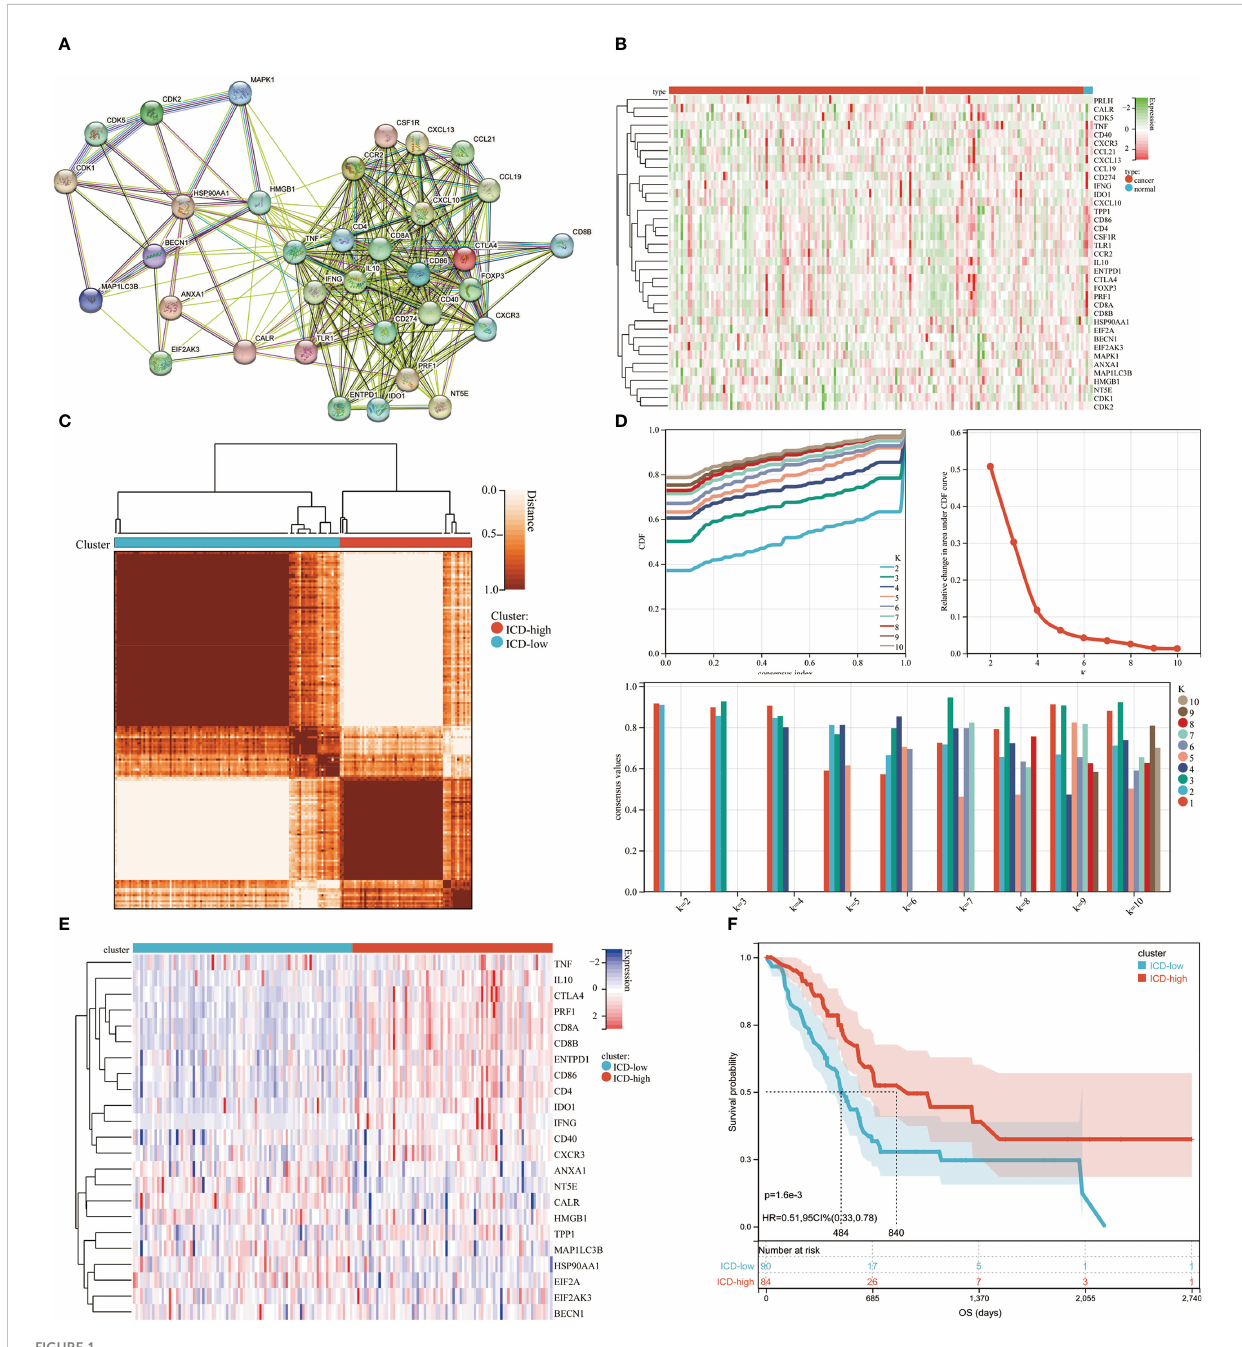
FIGURE 1 Consensus clustering for the identi fi cation of subtypes related to ICD. (A) PPI (Protein-protein interactions) among the genes related to ICD; (B) The TCGA database heatmap displays 37 ICD gene expression patterns in normal and PDAC samples; (C) The consensus clustering solution (k = 2) for 23 genes in 176 PDAC samples is represented by a heatmap; (D) Consensus clustering ’ s delta area curve showed the change in area under the cumulative distribution function (CDF) curve for k = 2 to 10; (E) Heatmap of 37 ICD-associated genes ’ expression levels across various subtypes. Blue symbolized low expression, whereas red denoted high expression; (F) ICD-high and ICD-low subtype OS Kaplan-Meier